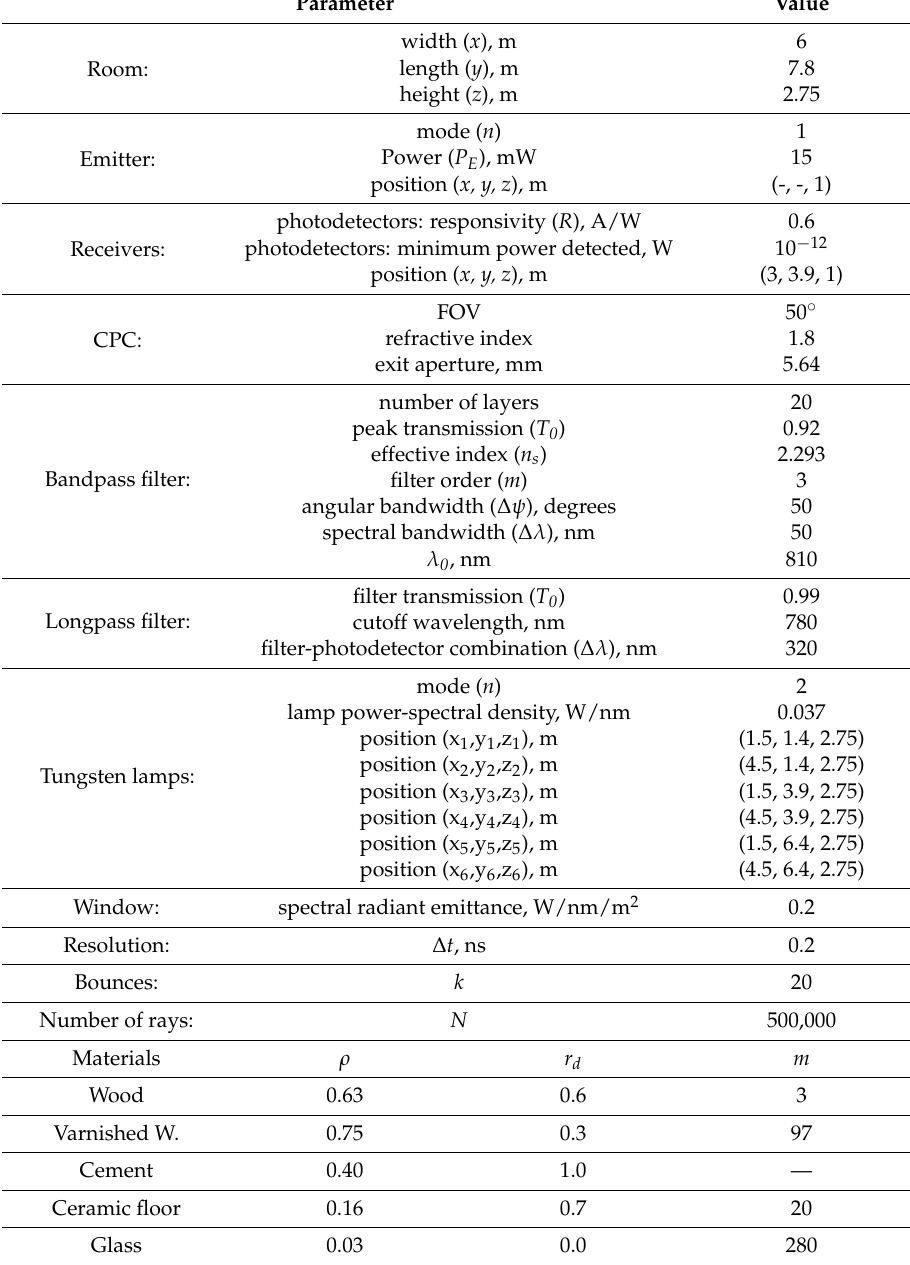
Table 1. Simulation